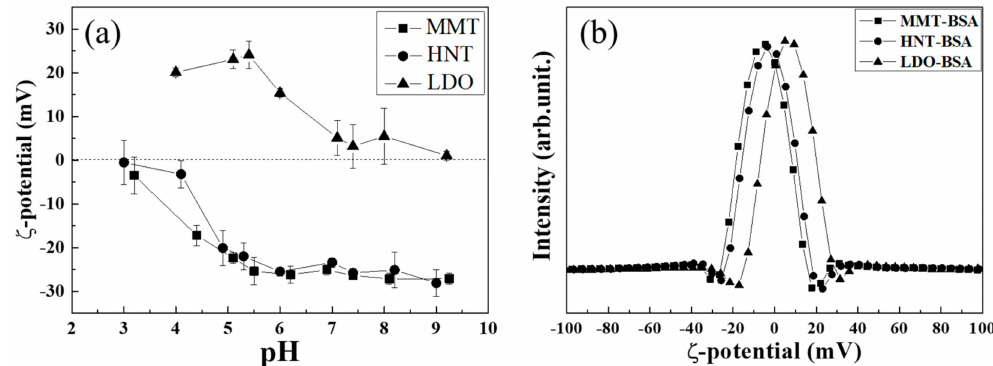
Figure 4. ( a ) pH dependent zeta potential of clays and ( b ) zeta potential value distribution pattern of clay with BSA in DPBS.